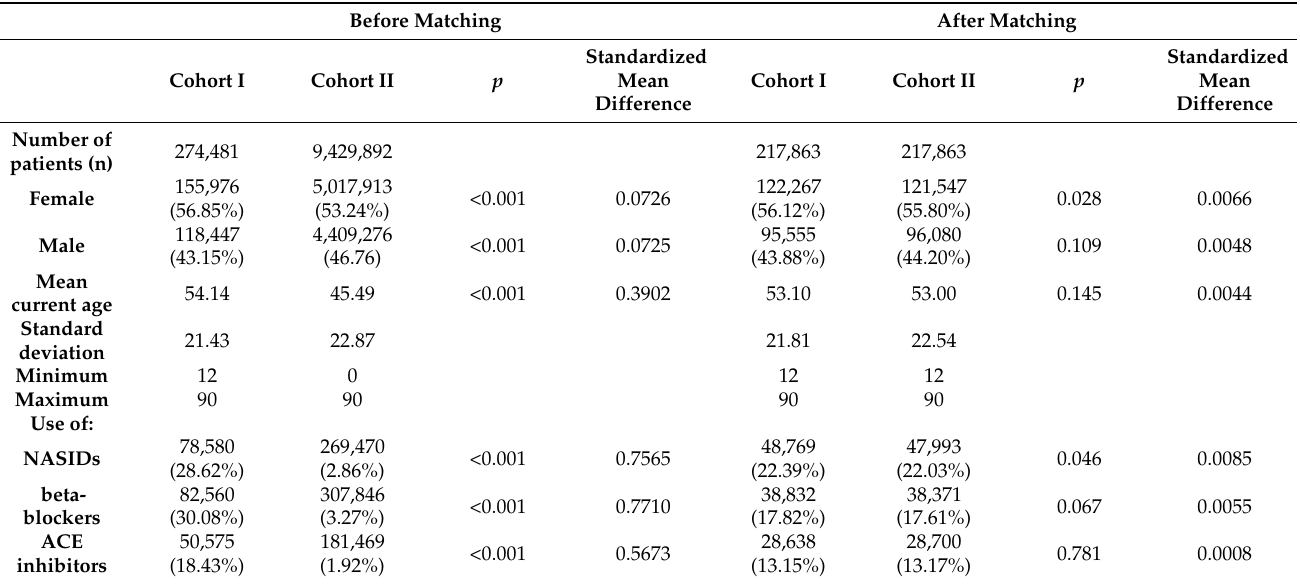
Table 1. Demographic characteristics and the frequencies of the use of NSAIDs, beta-blockers and ACE inhibitors of the cohorts I and II after matching process.